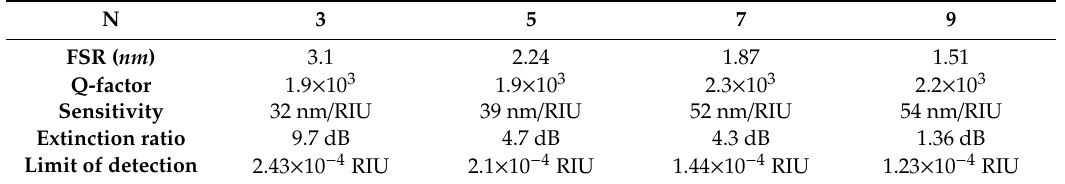
Figure 6. Transmission spectrum according to N when the background index of the S-bend resonator is 1 and 1.01: ( a ) N = 3; ( b ) N = 5; ( c ) N = 7; ( d ) N = 9. Table 2. Detailed performance indexes of the S-bend resonator according to N.